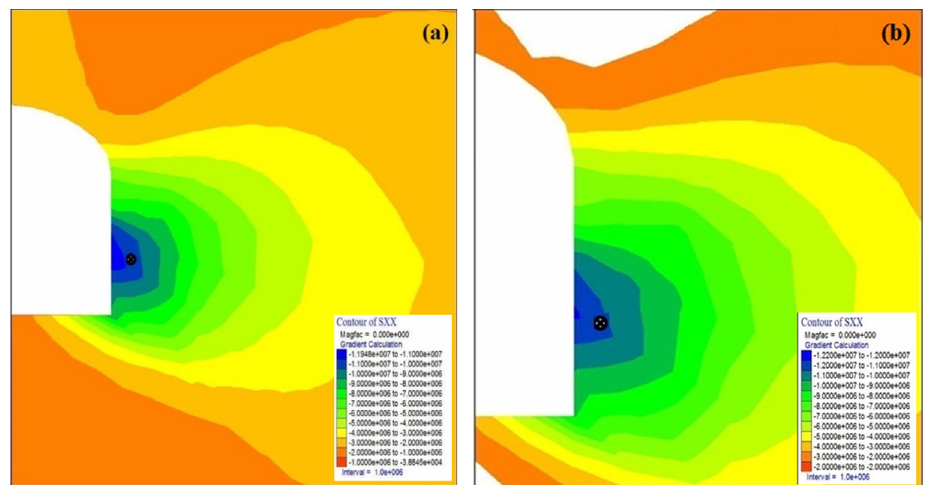
Figure 14. Induced stress state (Pa) in the direction of loading for two plate diameters in an in-situ plate load test, ( a ) loading plate diameter of 80 cm ( b ) loading plate diameter of 100 cm.